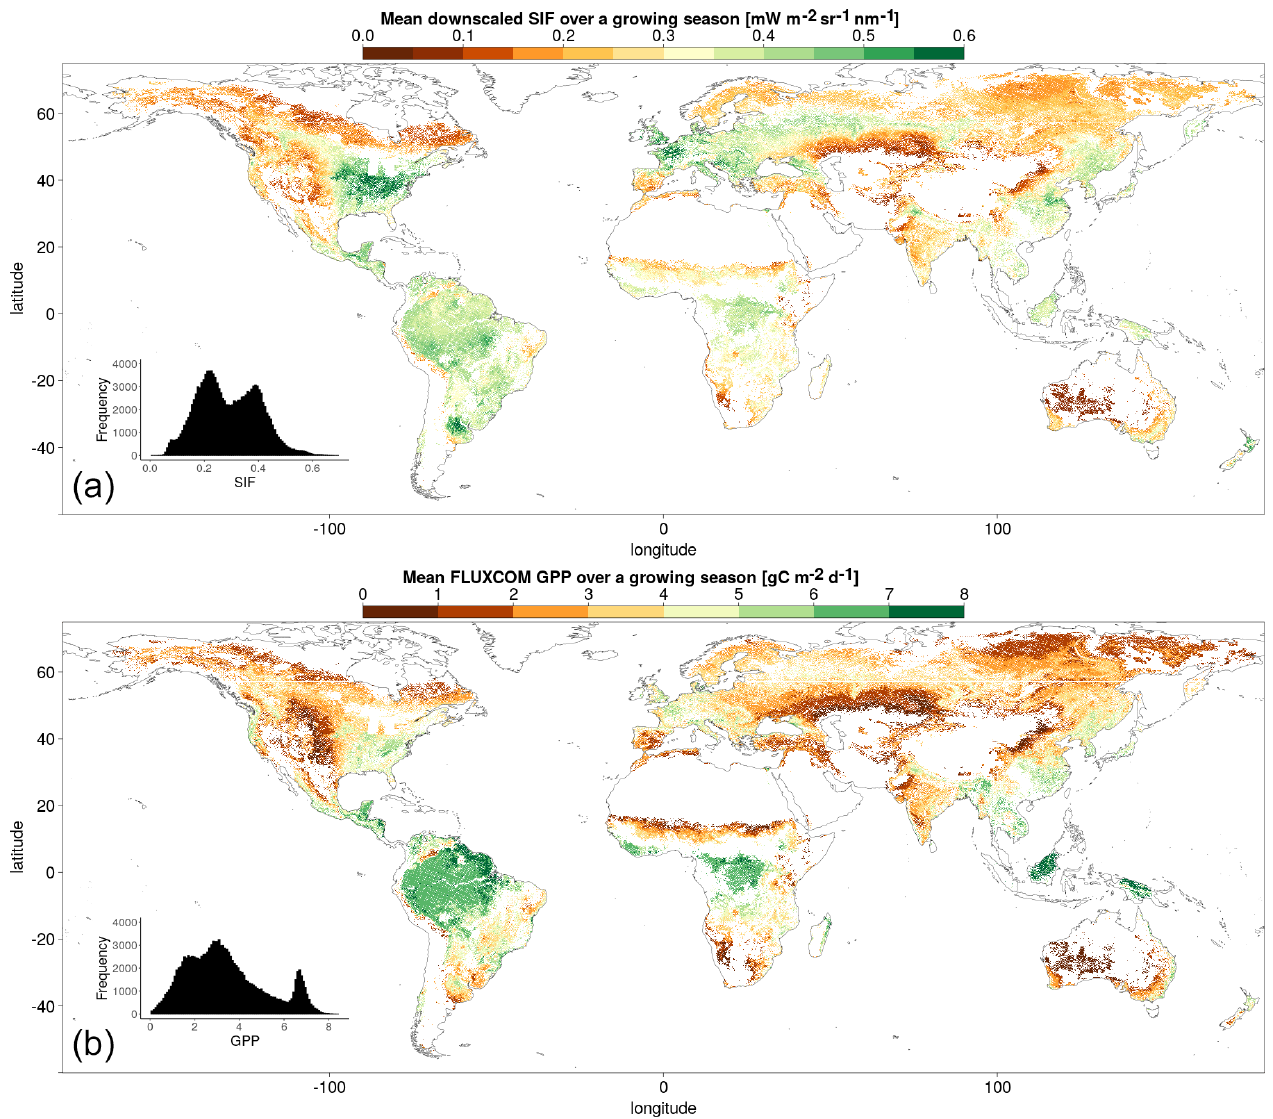
Figure 2. Mean downscaled SIF (a) and FLUXCOM GPP (b) over the growing season, corresponding to each of the pixels passing the full set of selection requirements. The SIF DS fluxes and GPP FX estimations for each pixel are averaged over multiple years between 2007 and